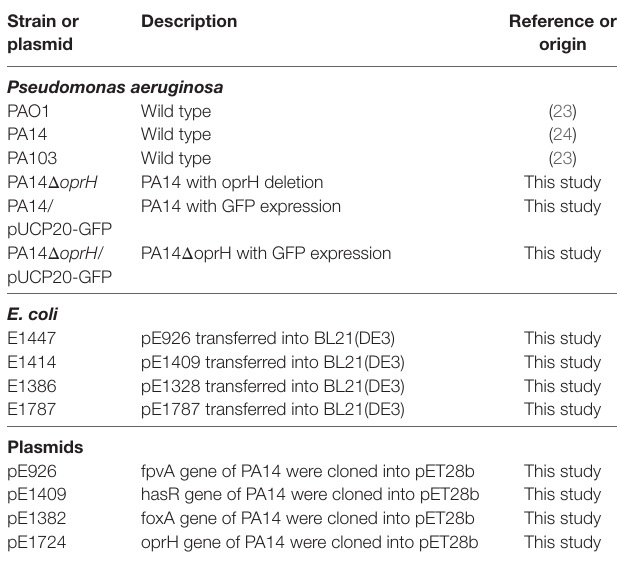
TaBle 1 | Strains and plasmids used in this